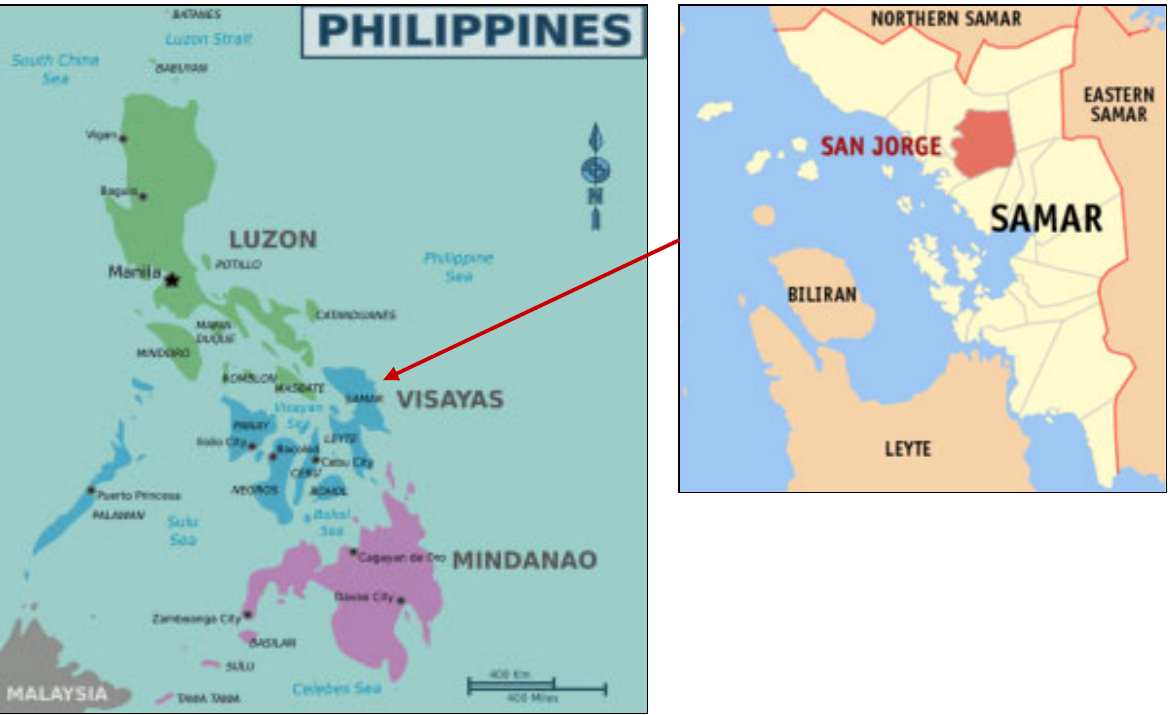
Figure 1. The Philippines and San Jorge,